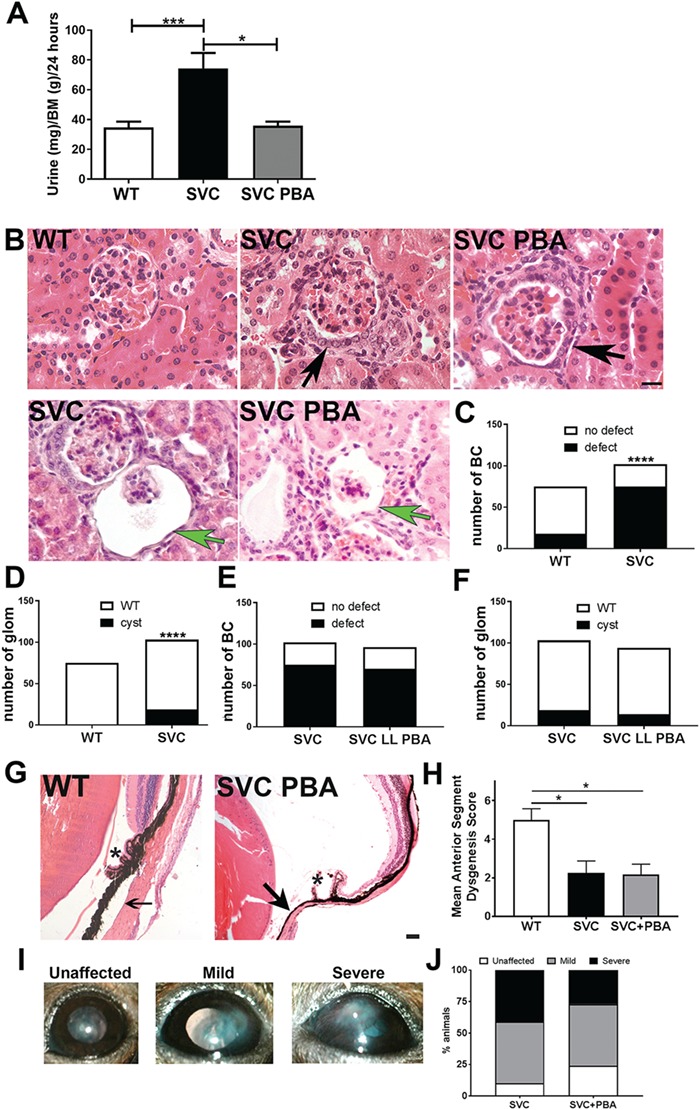
Effect of PBA treatment on adult eye and renal defects. (A) Daily urine output of five-month-old untreated WT littermate, untreated Col4a1+/SVC mice and treated Col4a1+/SVC (WT n = 20, SVC n = 18, SVC PBA n = 6). (B) Haematoxylin and eosin staining of kidneys revealed in untreated Col4a1+/SVC (SVC) and PBA-treated Col4a1+/SVC mice (SVC PBA) defects (cuboidal appearance, formation of multiple cell layers) of parietal epithelial cells of Bowman’s capsule (black arrow) and glomerulocystic kidney disease (retraction of vascular tuft, green arrow). SVC: untreated Col4a1+/SVC. (n = 4). (C) Image analysis of Bowman’s capsules in WT (n = 75 capsules) and Col4a1+/SVC (n = 102) (χ2 = 42.52; 1 df). (D) Image analysis of glomerulocystic kidney disease in WT (n = 75 glomeruli) and Col4a1+/SVC (n = 102) (χ2 = 15.49; 1 df). (E) Image analysis reveals similar frequency of Bowman’s capsule defects in treated (n = 84) and untreated (n = 102) Col4a1+/SVC. (χ2 = 0.009; 1 df) (F) Image analysis reveals similar frequency of cystic defects in treated (n = 103 glomeruli) and untreated (n = 94) Col4a1+/SVC (χ2 = 0.44; 1 df). (G) Haematoxylin and eosin staining of eyes revealed persistence of ASD defects in treated mice (SVC PBA) including iridocorneal adhesion (arrow), atrophy of the ciliary body (*) size bar = 50 μm. (H) Scoring of anterior segment (presence/absence of iridocorneal adhesion, ciliary body morphology, presence/absence of open Shlemm’s canal) in WT, untreated (SVC) and treated mutant (SVC + PBA) mice. (WT n = 4, SVC n = 4, SVC PBA n = 6 mice). (I) Slit lamp analysis revealed persistence of opacity of the cornea (scoring system applies only to corneal opacity) and iris hypoplasia in treated mice. Corneal neovascularization (see `severe’ panel) is also observed. The right panel is the graphical representation of the scoring of corneal opacity. (SVC n = 6, SVC PBA n = 4 animals). (J) Image analysis of corneal opacity scoring. (C)–(F): Two-sided chi-square test; (A), (H): One-way ANOVA post hoc Sidak test *P-value<0.05, ****P-value <0.0001.